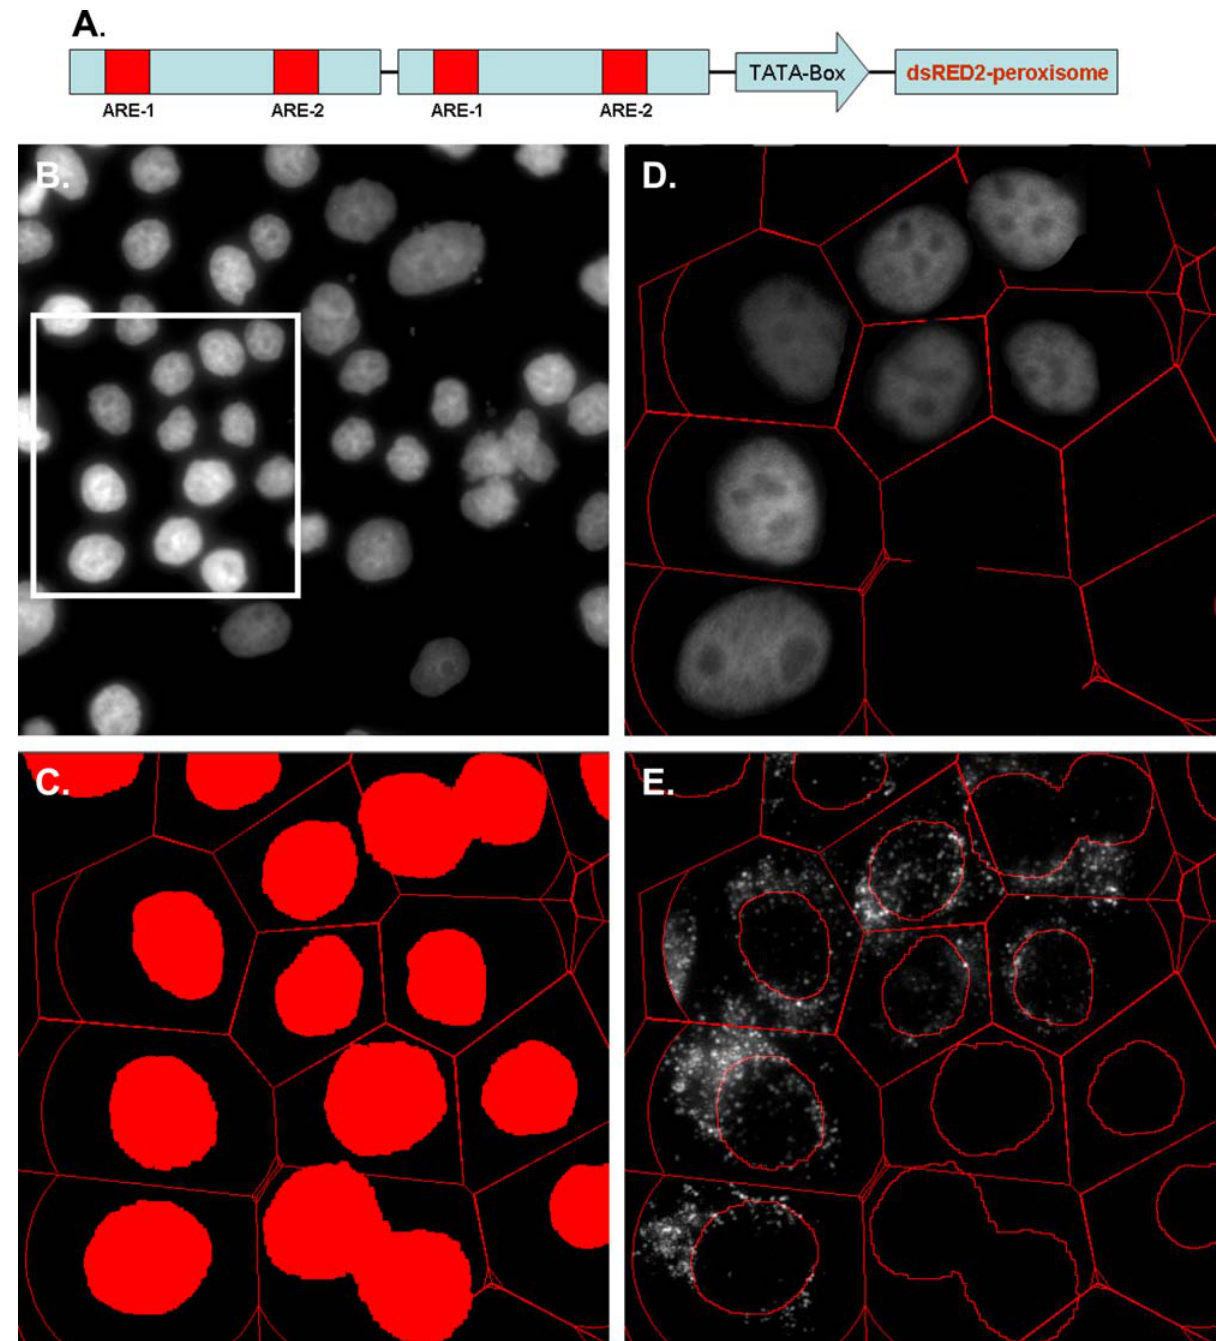
Figure 3. Multiple 6 assay automated image analysis. A. The probasin proximal promoter element containing two AR binding sites duplicated and fused to a peroxisomes-targeted dsRED2skl protein reporter. B. Raw gray-scale image of HeLa cell nuclei stained with DAPI. White box indicates view used in rest of figure. C. Binary nuclear mask generated by non-linear least squares image filter and image field segmentation based on nuclear centroids and veronoi tessellation. This tessellation in combination with a user defined radius rule defines cytoplasmic compartment of each cell. D. Virtual pseudo color well image generated after GFP-AR data extraction. E. AR transcriptional reporter gene activity at single cell level determined by dsRED2skl image data extraction. All screen captures directly from Cytoshop with various features toggled on/off. doi:10.1371/journal.pone.0003605.g003 dsRED2skl (reporter protein, red). Cytoshop (Beckman Coulter) or